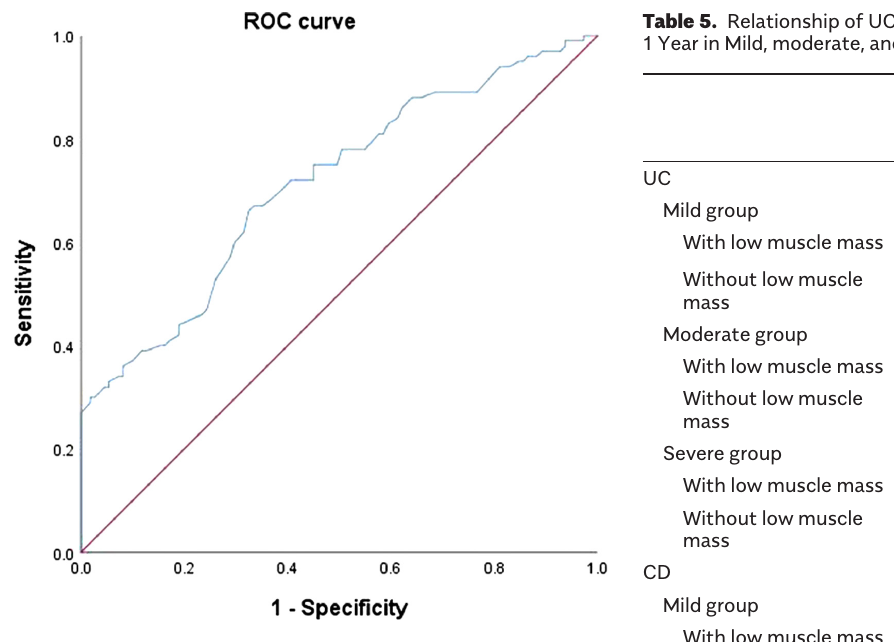
Figure 3. ROC curves of VFA/SFA and time to readmission within 1 year. VFA, visceral fat area; SFA, visceral fat area.